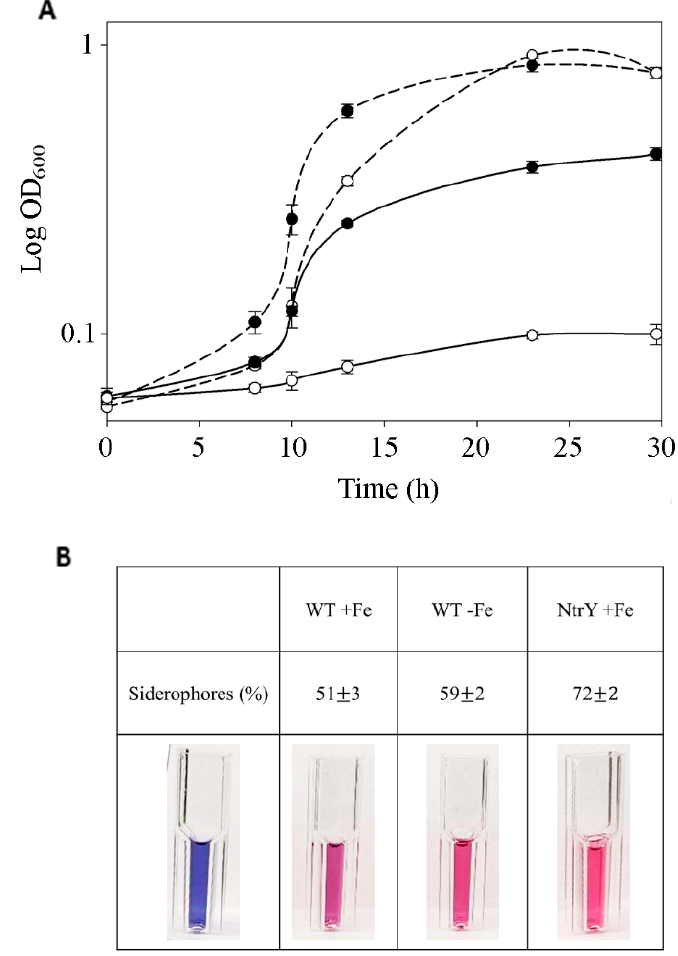
Figure 4. Growth and siderophores production of the P. denitrificans wild-type strain and NtrY mutant in iron-rich or iron-depleted medium. ( A ) The wild-type strain (black circles) and NtrY mutant (white circles) were grown under iron-rich conditions (discontinuous lines) or under iron-depleted conditions (continuous lines) in minimal media with 30 mM nitrate as the sole nitrogen and energy sources under anaerobic and denitrifying conditions. ( B ) Aliquots from the cultures (OD 600 ∼ 0.6) were taken and centrifuged, the resulting supernatants were used to assay siderophores production by using Chrome Azurol S (CAS), as described in Materials and Methods section. A control without addition of supernatant was performed (blue), the presence of siderophores was determined colorimetrically at 630 nm (pink). Error bars correspond to data from three independent replicates (n = 3).